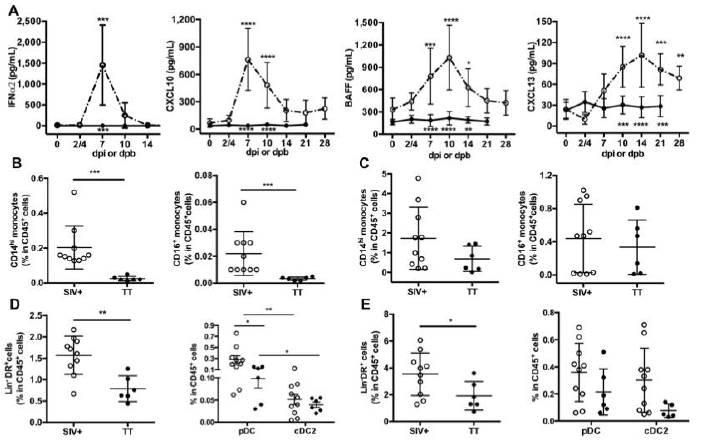
Figure 2. Circulating inflammatory cytokines and proportions of antigen-presenting cells in lymphoid organs. ( A ) ELISA was used to quantify serum levels of IFN α 2 and CXCL13, whereas serum CXCL10 and BAFF were detected by using a magnetic Luminex kit. Samples were tested prior to infection or to booster injection (baseline value, D0) and at different time points post-infection (dpi) or post-boost (dpb). Mean ± SD values for group of SIV-infected macaques ( open circle , dotted line ) or TT-vaccinated macaques ( black circle; plain line ) at the various time points are given. Statistical comparison between values at D0 and at every time point post-infection (Group SIV + ) or post-boost (Group TT) was carried using a Friedman test with Dunn’s multiple comparisons test. Statistically significant values are indicated above dotted lines. Comparison between values of each group at every time point was carried using 2-way ANOVA with Bonferroni’s multiple comparisons test. p values are indicated below the plain lines: ** p < 0.01 , *** p < 0.001 , and **** p < 0.0001. Proportions of CD14 hi and CD16 + monocytes in CD45 + cells from Group SIV + and Group TT were compared in LNs ( B ) and spleen ( C ). Proportions of Lin - DR + cells in CD45 + cells from Group SIV + and Group TT are shown in LNs ( D , left panel) and spleen ( E , left panel). Proportions of pDC and cDC2 in CD45 + cells are given in LN ( D , right panel) and spleen ( E , right panel). For ( B – E ) each dot represents one macaque from Group SIV + ( open circle ) or TT ( black circle ). Bars represent Mean ± SD. Statistical comparison between groups was performed using Mann Whitney non-parametric test. Statistically significant values are indicated * p < 0.05 , ** p < 0.01 and *** p < 0.001 .